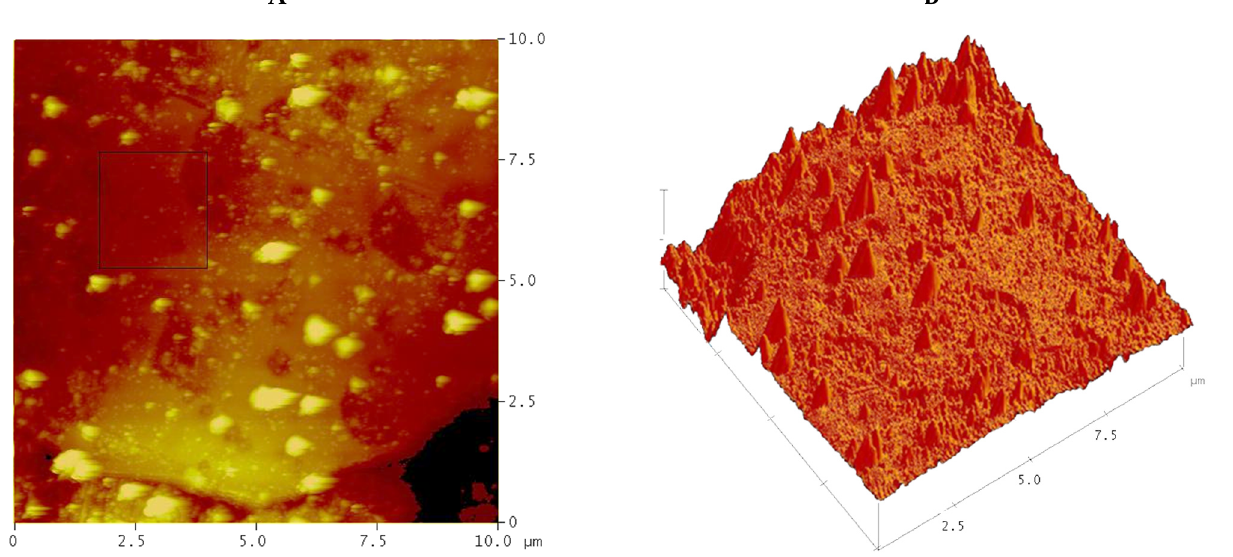
Figure 4. AFM of copper post-electropolishing with phosphoric acid in 2D ( A ) and 3D ( B ), recording an average roughness of 82.6 ± 6 nm by utilizing the roughness average method for calculation. A 10 × 10 µ m recording region was utilized. AFM Z -axis = 100 nm/div. The yellow pattern shown in the bottom center of A is an example of aberrant hydrogen